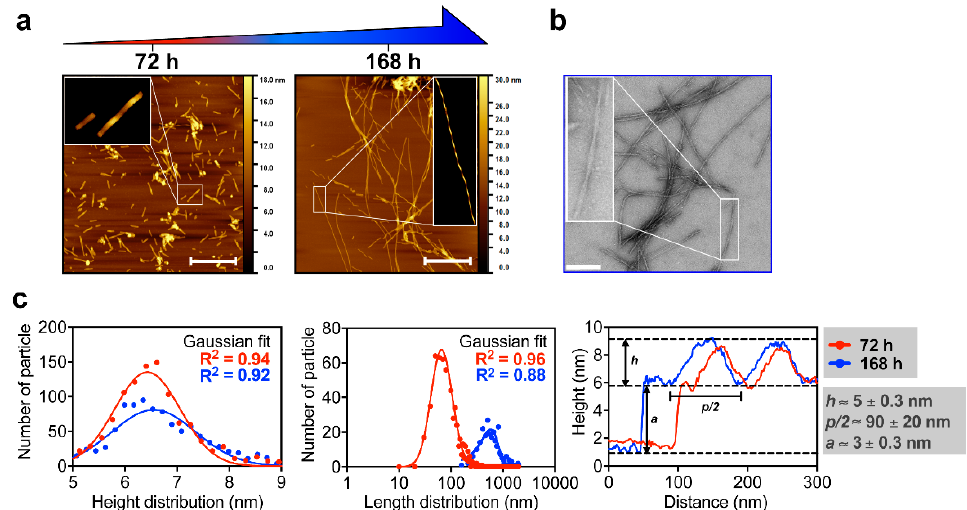
Figure 3. Morphological characterization of M2e-NFs. ( a ) Representative atomic force microscopy (AFM) images of M2e-NFs taken after 72 h and 168 h of self-assembly showing the morphology of the nanostructures. Scale bar is 200 nm. ( b ) Representative TEM image of M2e-NFs obtained after 168 h self-assembly. Scale bar is 100 nm. ( a , b ) Insets are zoomed in region of the images taken at high resolution with further digital treatments to highlight the twisted morphology of NFs. ( c ) Height and length distribution, and height profiles of M2e-NFs at 72 h (red line) and 168 h (blue line) self-assembly extracted from AFM images. h , p/2 and a on the height extraction profile graph correspond to height, half of the pitch, and amplitude, respectively.